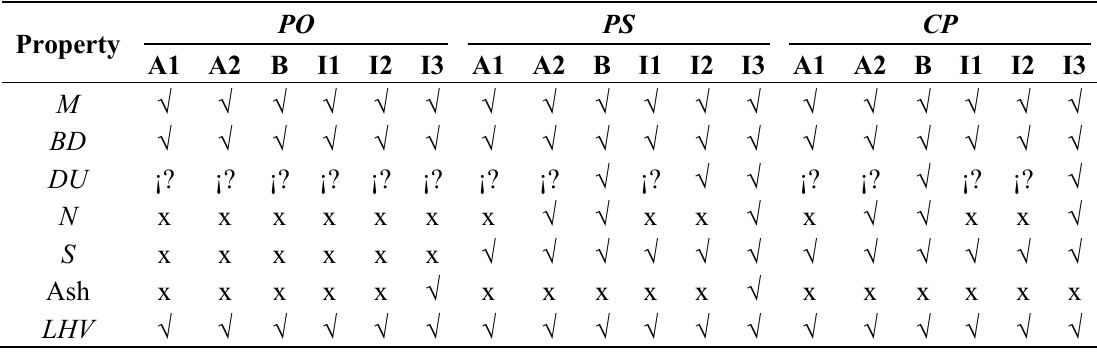
Table 5. Comparison with EN ISO 17225-2 standard (part 1).